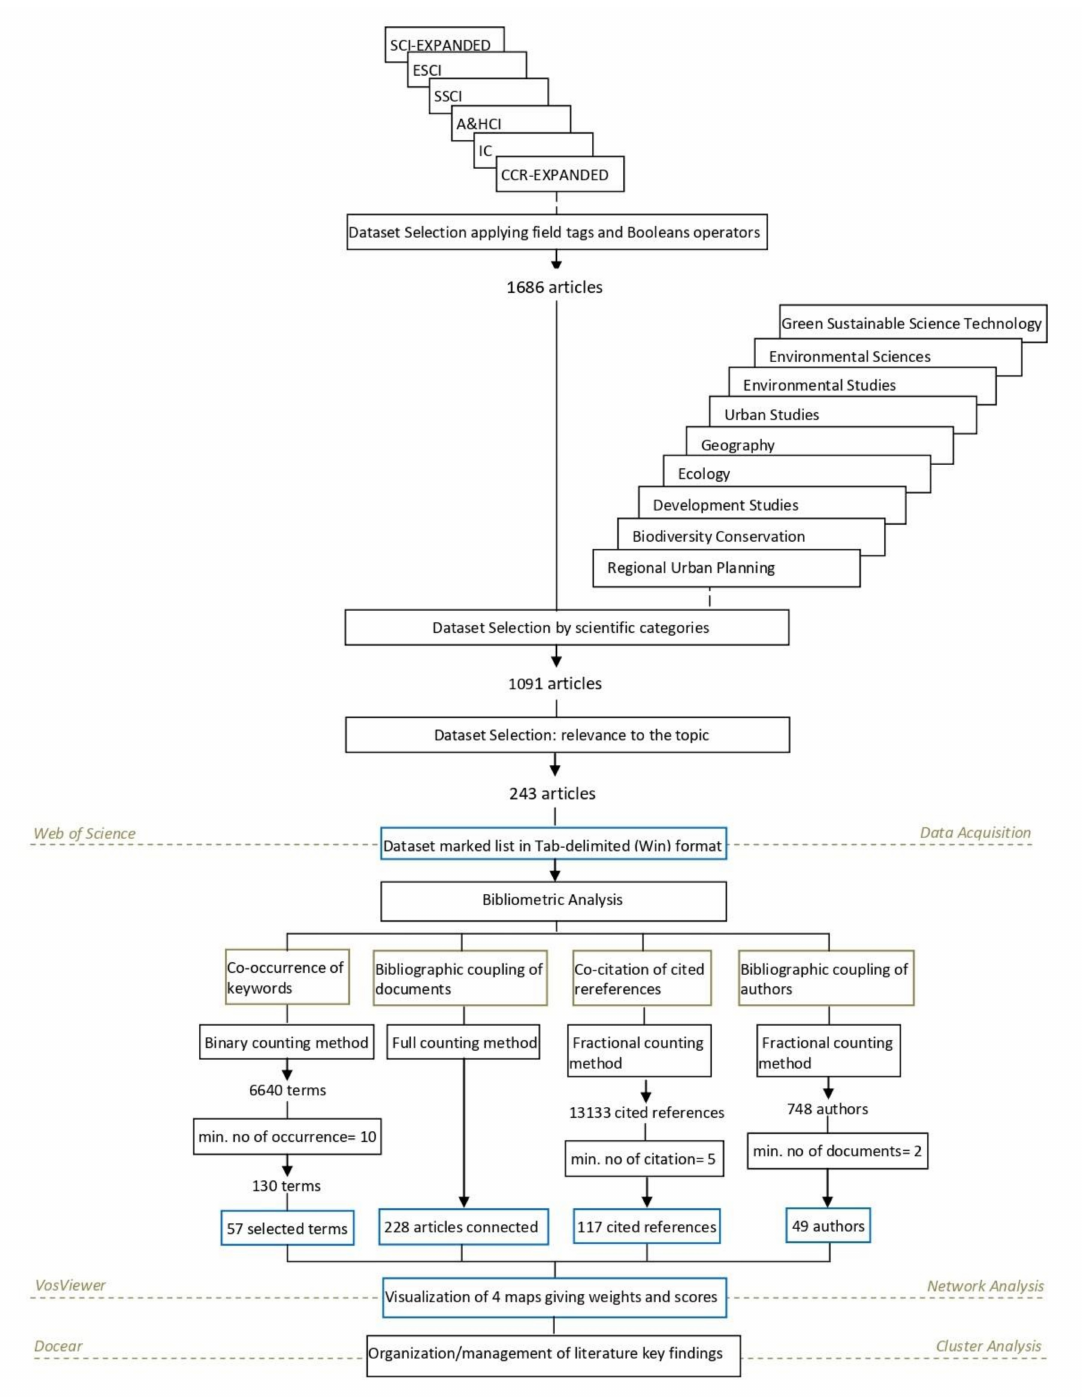
Figure 1. Flowchart of the developed